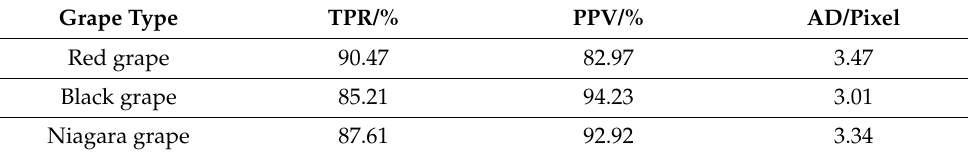
Table 1. Detection and analysis of pits of different types of grape